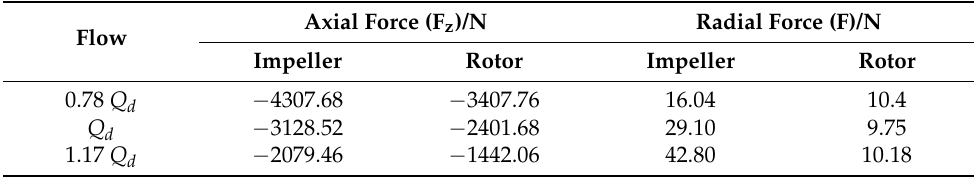
Table 2. Axial and radial forces of rotor and